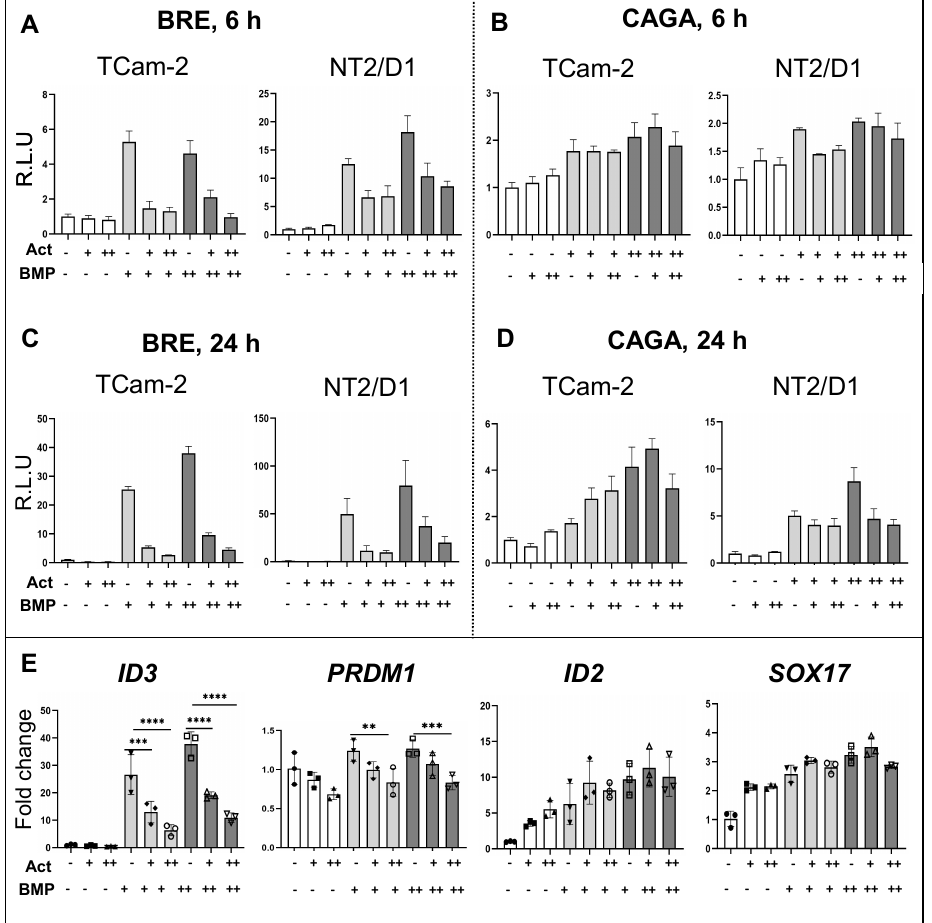
Figure 4. Transcript levels and signalling outcomes show activin A affects BMP signalling acti- vation. TCam-2 and NT2/D1 cells infected with the adenoviral BMP response element reporter construct, Ad-Bre-F-Luc (BRE), and adenoviral activin response element reporter construct, Ad- CAGA-G-Luc (CAGA), were stimulated with activin A (Act) or BMP4 (BMP) at 5 ng/mL (low dose, denoted by ‘+’) and 25 ng/mL (high dose, ‘++’) or by both factors at the indicated doses.